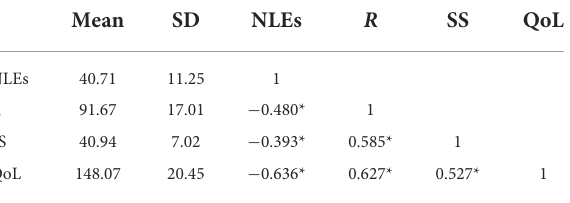
TABLE 2 Correlations, means, and standards deviations of study variables.